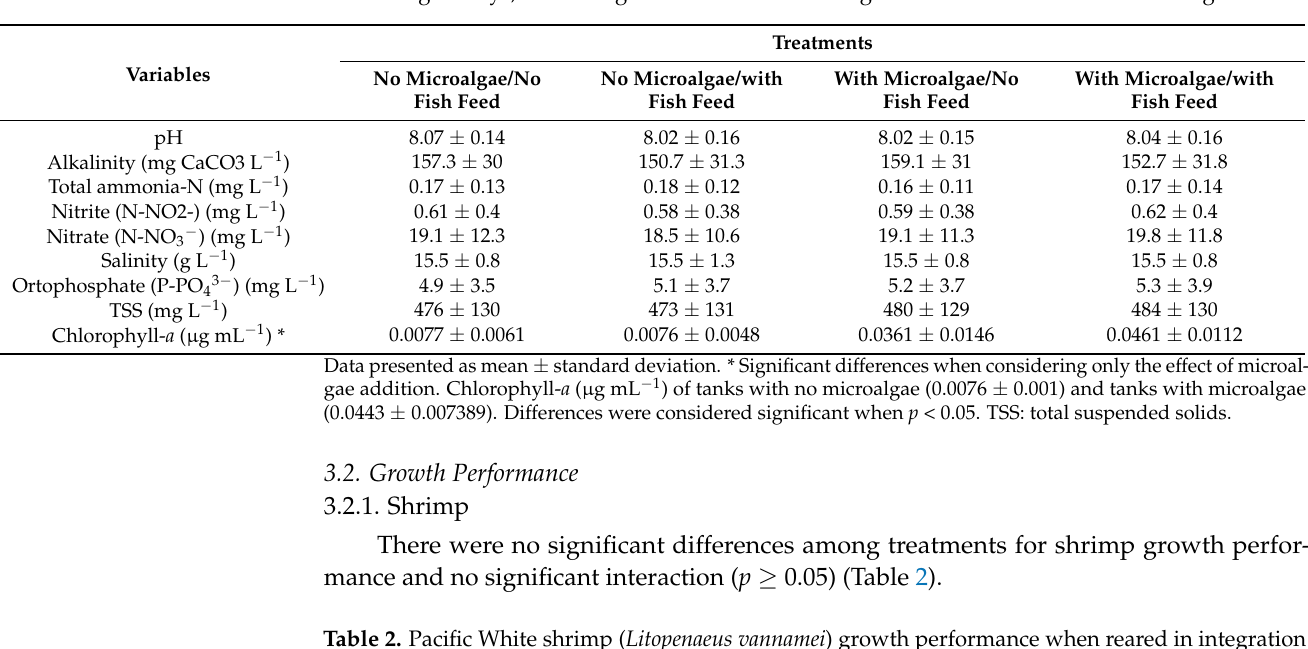
Table 1. Water quality physico-chemical variables of a Pacific white shrimp ( Litopenaeus vannamei ) and Nile tilapia ( Oreochromis niloticus ) integrated system using biofloc technology which was carried out during 62 days, evaluating the addition of microalgae and fish feed in a factorial design.